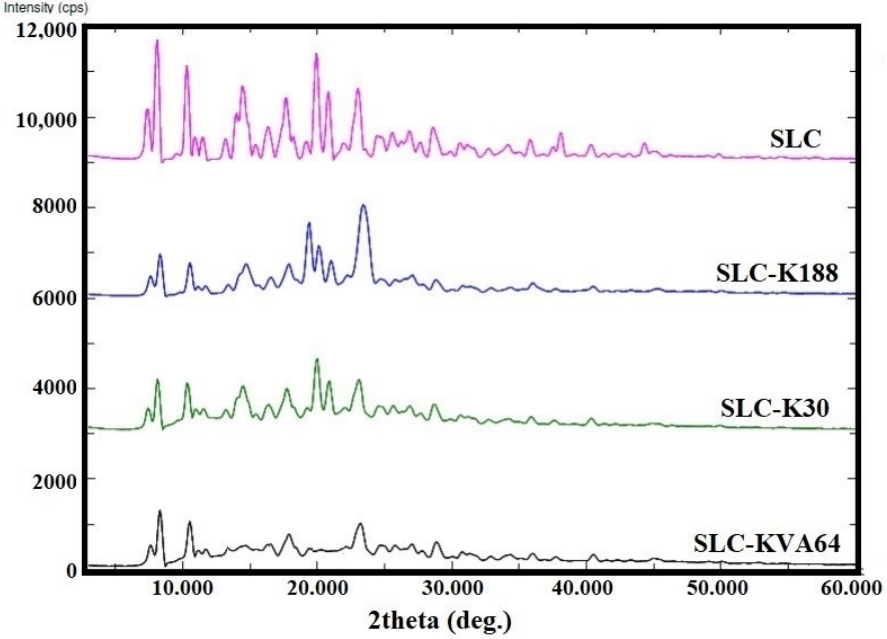
Figure 4. Comparative PXRD spectra of pure SLC, SLC-K188, SLC-K30, and SLC-KVA64.